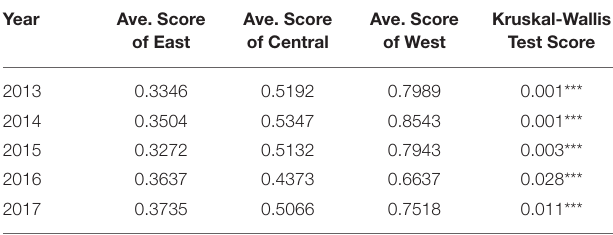
TABLE 5 | Kruskal-Wallis test score of total